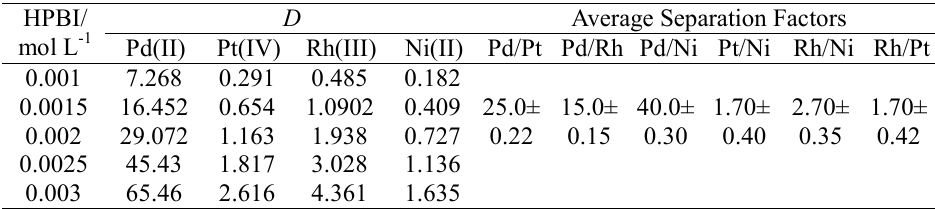
Table 2. Separation of Pd(II) from Pt(IV), Rh(III), Ni(II)(1.12 × 10 -4 mol L -1 ) chloride (0.05 mol L -1 H + ) solutions using HPBI.